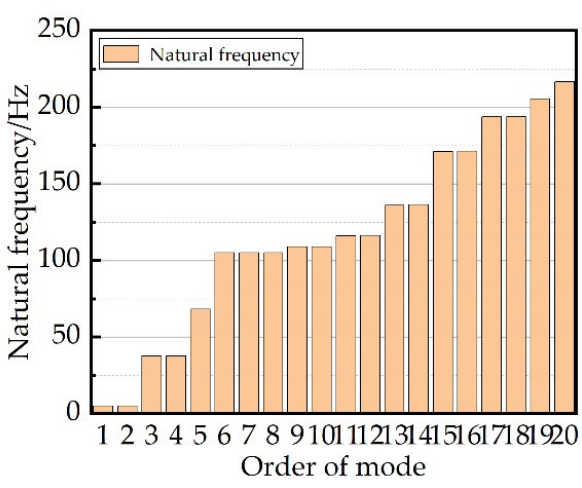
Figure 18. Natural frequency of each order. Table 10. Natural frequency of vehicle.